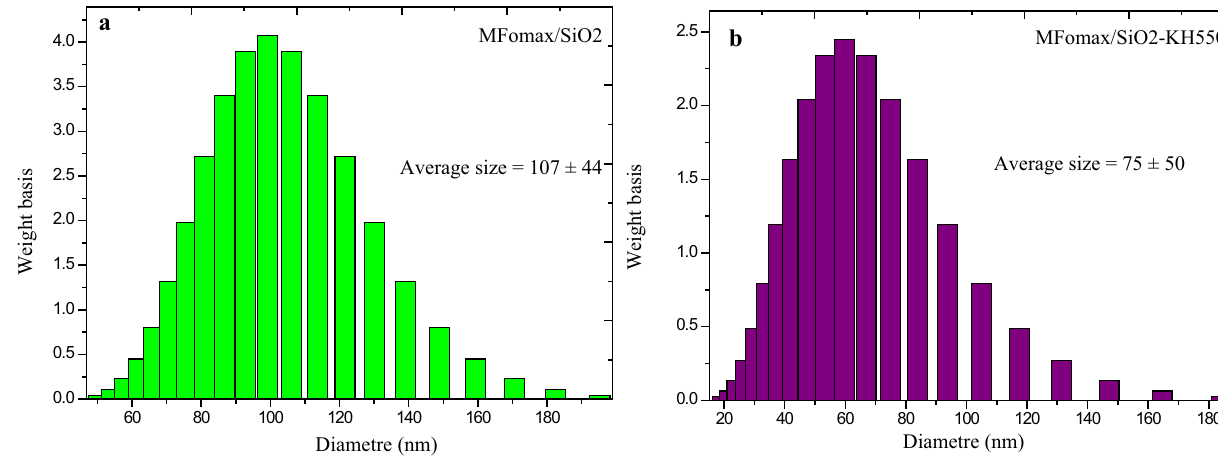
Fig. 5 Particle size distribution and aggregation of the NFs; a MFomax/SiO